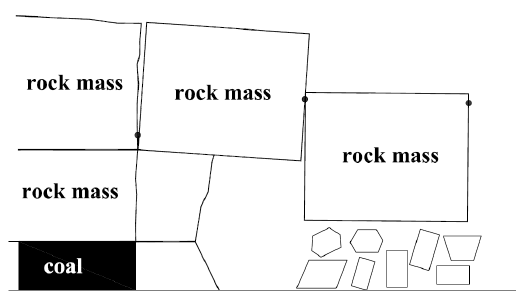
Figure 4. Schematic of arch beam model.